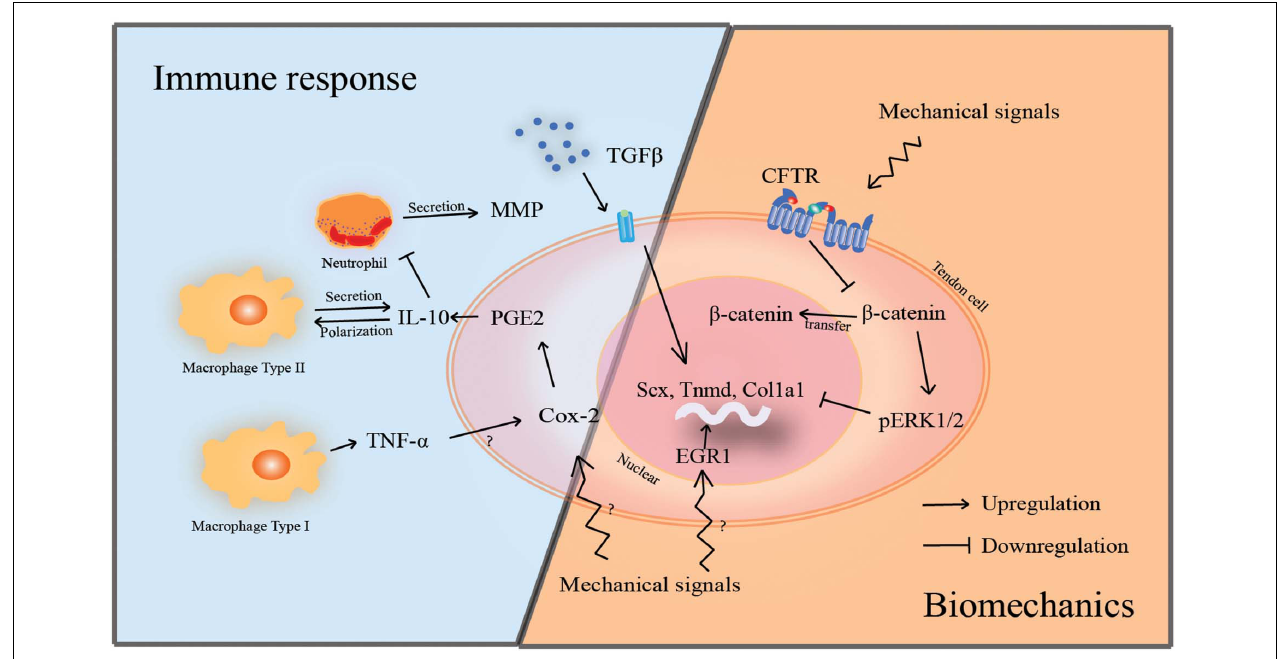
FIGURE 3 | Both mechanical signals and immune response can regulate tendon cells and further influence tendon regeneration. Inflammation and mechanical signals can control the tenogenic differentiation by regulating the transcription of tendon markers in tendon cells. Some cytokines and mechanical signals have the same targets, indicating a kind of potential co-regulation pathway. However, most mechanosensitive proteins are unknown, and the inflammation process still needs a deeper understanding. In that, it is necessary to figure out the mechanism of the balance between biomechanics and immune response during tendon